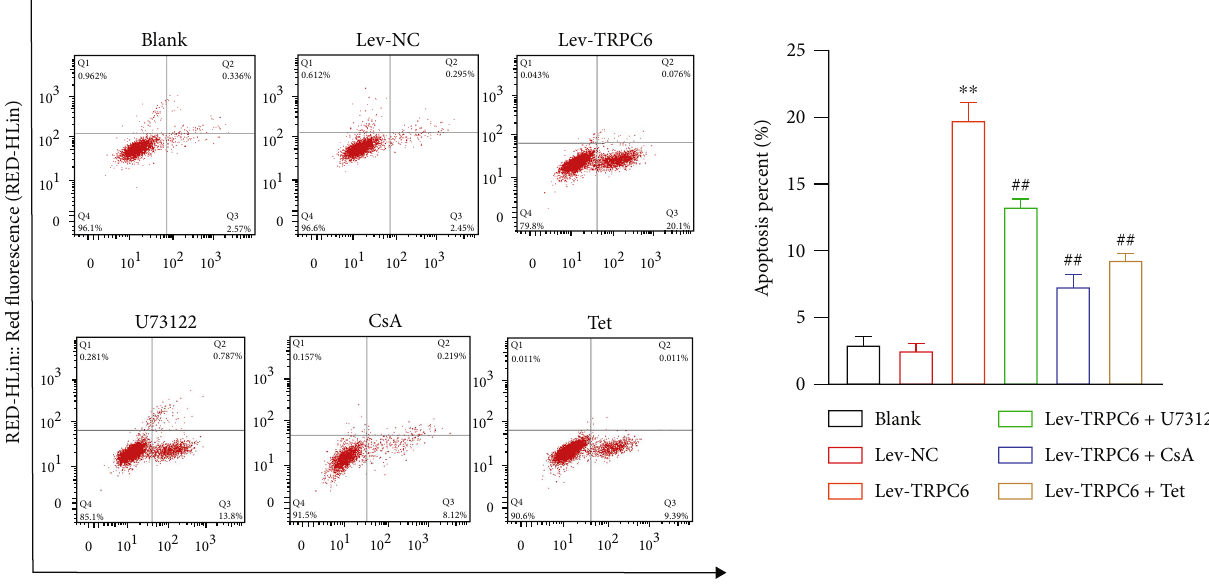
Figure 5: Tetrandrine (Tet) represses apoptosis of podocytes via targeting TRPC6. The apoptosis percent of MPC5 podocytes was detected by fl ow cytometry analysis. ∗∗ P < 0 : 01 versus the lev-NC group. ## P < 0 : 01 versus the lev-TRPC6 group. MPC5 podocytes were transfected with lev-NC or lev-TRPC6 and then treated with U73122 (an inhibitor of TRPC6 channel opening), CsA, or